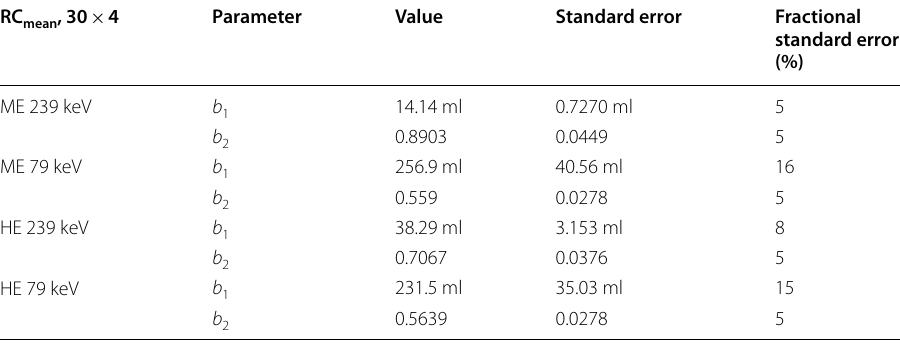
4 reconstruction with a 12‑mm Gaussian ×